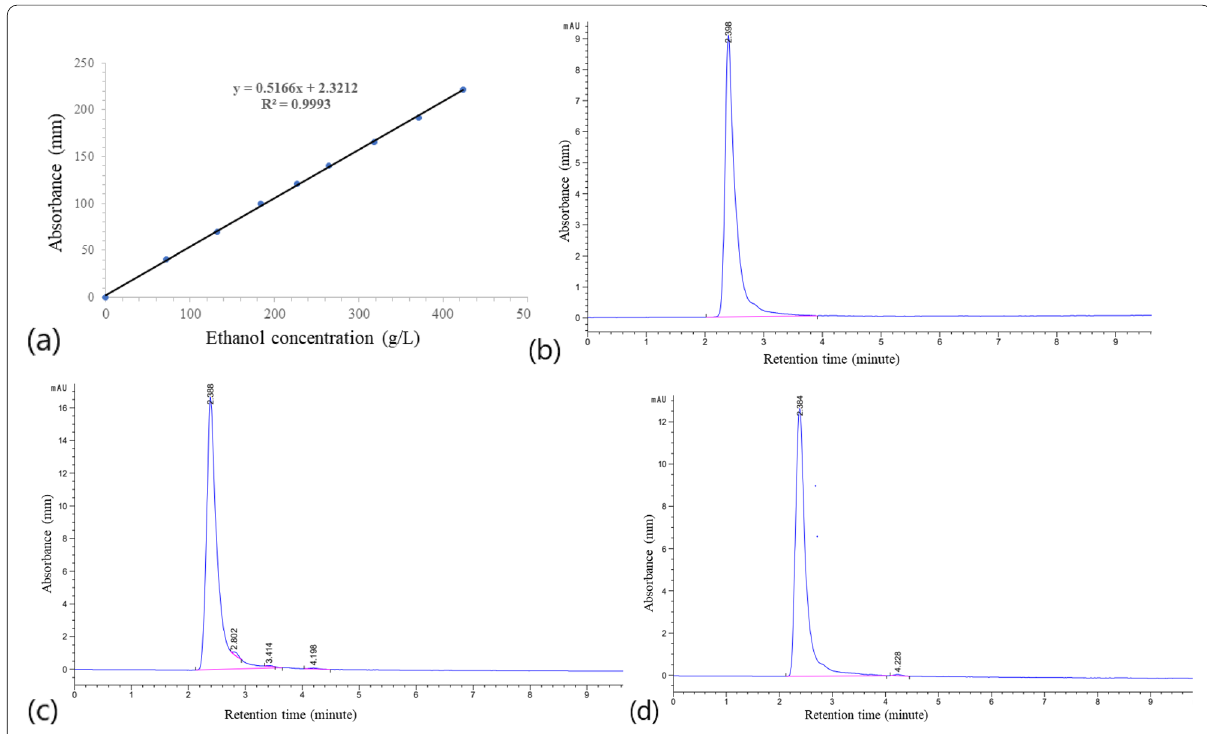
Fig. 7 Standard ethanol calibration curve ( a ), standard ethanol concentration chromatogram at 30% dilution ( b ), maximum ethanol concentration chromatogram among experimental runs ( c ), and validation experiment under optimum operating conditions ( d